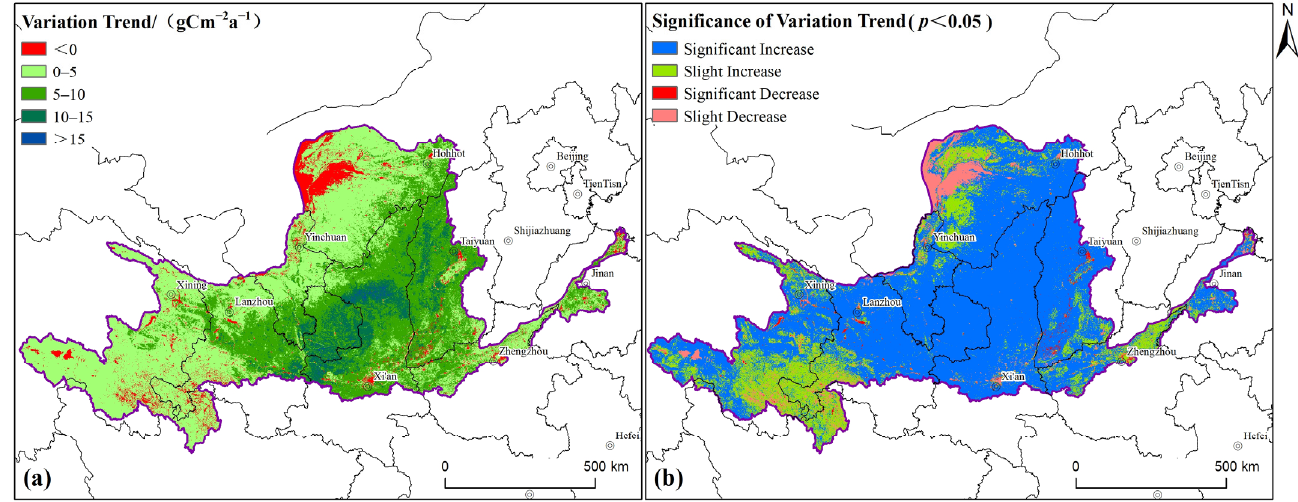
Figure 8. Partial correlation coefficient and significance test results of NEP and precipitation. ( a ) The partial correlation coefficient between NEP and precipitation, divided into 10 categories according to equal intervals. ( b ) The grading results passing the significance (95%) test.